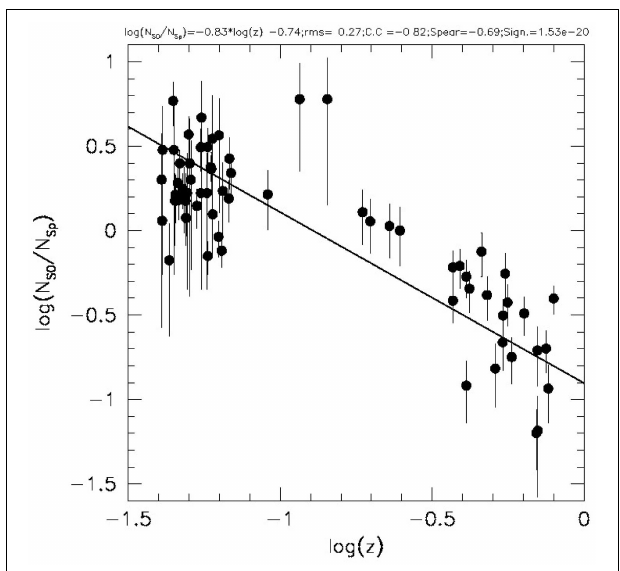
FIGURE 3 | Trend of the morphological fractions (E/Sp, S0/Sp, and S0/E) with redshift in various clusters. The WINGS stacked sample is shown with its 1 σ error bar. The plotted lines mark the evolution of the morphological fractions for a hypothetical cluster that at high redshift has the mean morphological fractions of the EDisCS sample. Spirals transform into S0’s and E’s at different rates per interval of redshift. Left: The solid lines